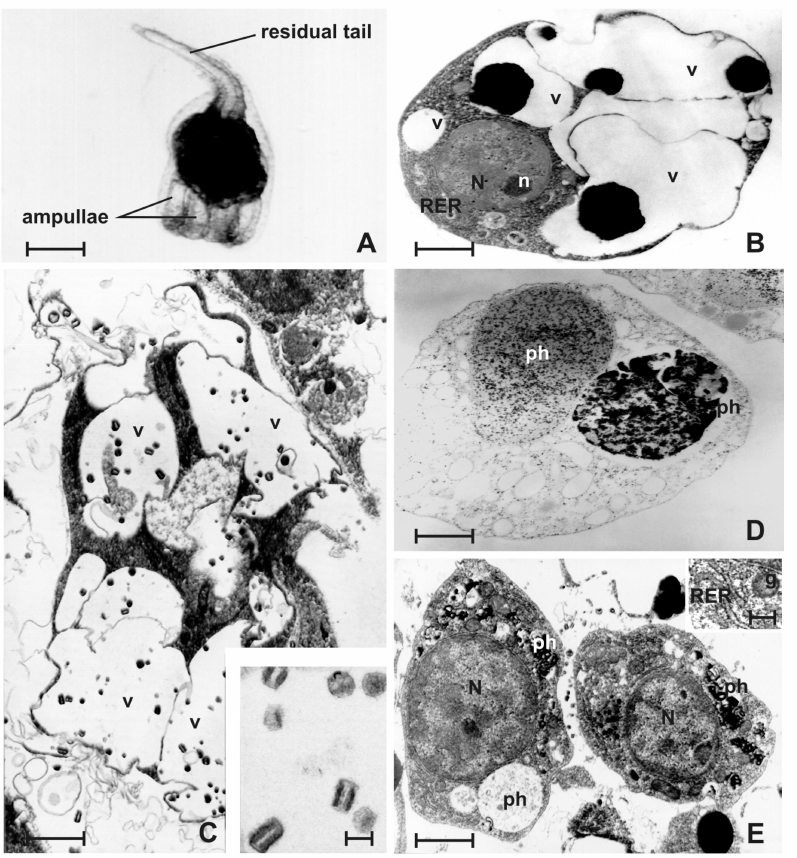
Figure 6. Late larval metamorphosis; ( A ) metamorphosing bell-shaped larva viewed in toto, show- ing partial resorption of the tail and protrusion of the ampullae; ( B ) morula cell; ( C ) pigment cell with evident pigment crystals of ‘blue phenotype’ inside vacuoles ( inset ); ( D ) macrophage-like cell. Phagosomes contain heterogeneous engulfed material and cell debris, and are labelled by the histochemical assay for the hydrolytic enzyme, acid phosphatase; and ( E ) two cells with interme- diate characteristics between hyaline amoebocyte and macrophage-like cell (see text for details). g —membrane-bound granule, N —nucleus, n —nucleolus, ph —phagosome, RER —cisternae of rough endoplasmic reticulum, and v —vacuole. Bar length: 200 µ m in ( A ); 1.2 µ m in ( B ); 1 µ m in ( C ) and ( E ); 1.7 µ m in ( D ); 0.1 µ m in inset of ( C ); and 0.2 µ m in inset of ( E